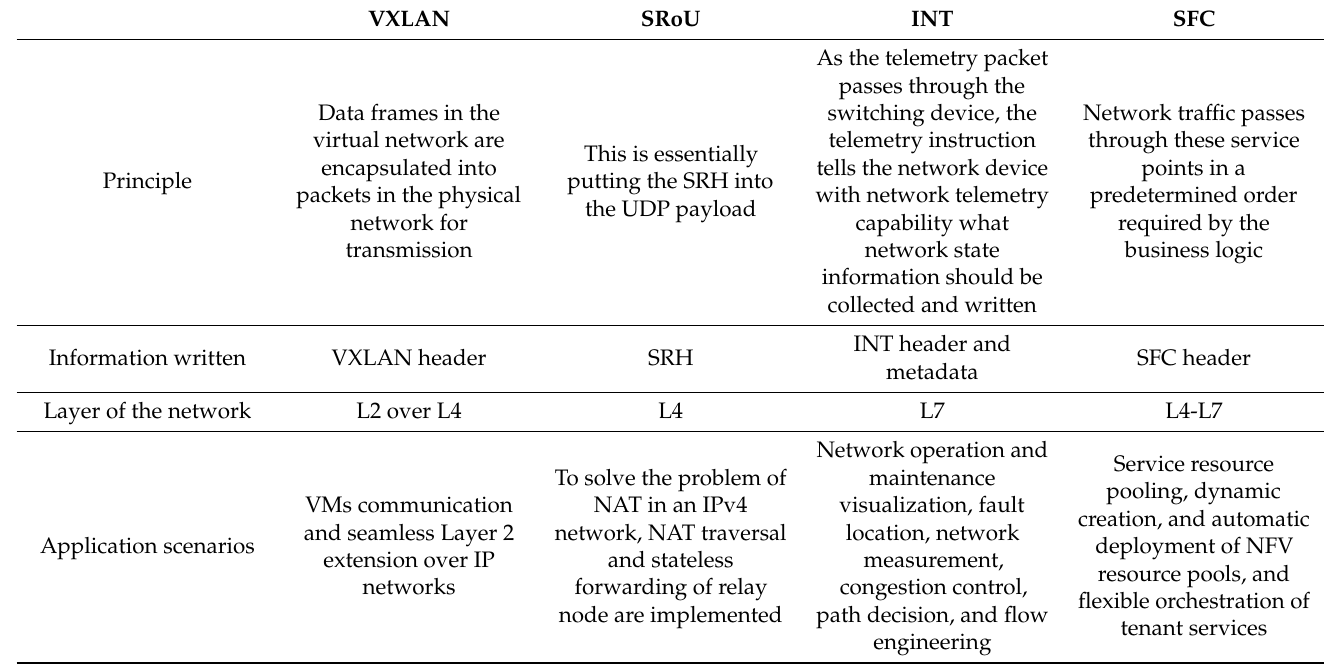
Table 3. Comparison and analysis of application